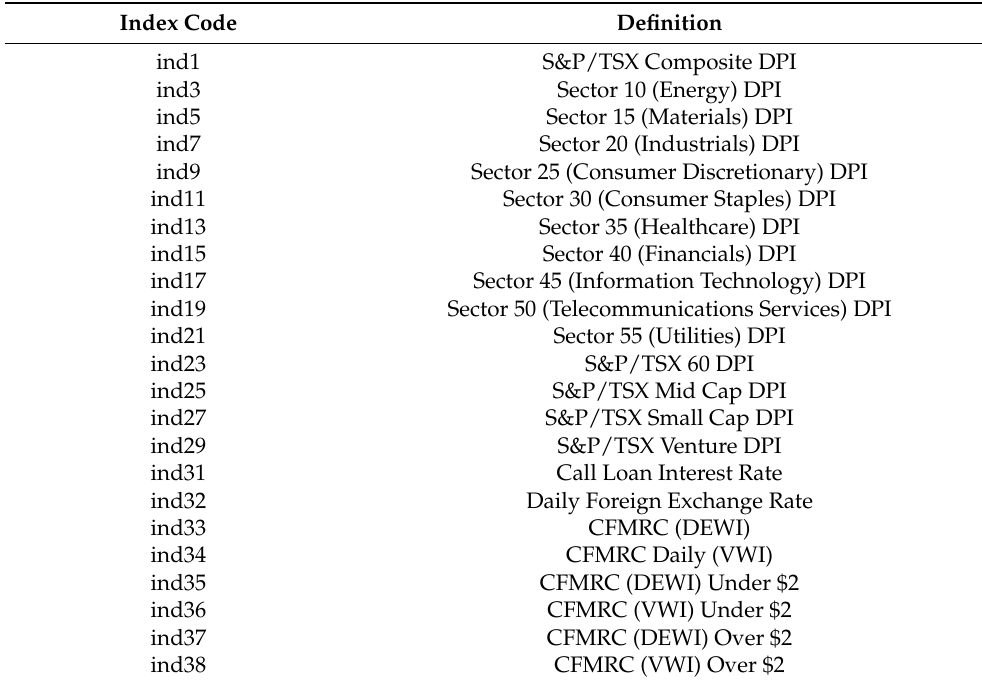
Table 1. Price index definitions.